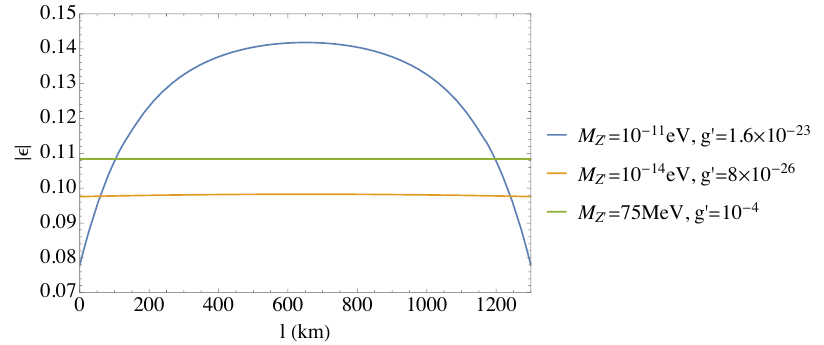
Figure 3 . Neutrino matter e(cid:11)ect in gauged L e (cid:0) L ‘ ( ‘ = (cid:22); (cid:28) ) model for three choices of g 0 and M Z 0 values. We consider a similar setup to DUNE, where neutrino travels 1300 km underground. For simplicity we assume both the source and the detector of neutrinos are located at the surface of the earth. In this case the largest depth of neutrino reaches is d max ’ 33 km, j (cid:15) j is plotted as a function of the distance l that neutrino has traveled. For the very short (long) range force case with M Z 0 (cid:29) d (cid:0) 1 ( M Z 0 (cid:28) d (cid:0) 1 ), we (cid:12)nd the j (cid:15) j is rough a constant as shown by the green (orange) max max curves; while for the intermediate range with M Z 0 (cid:24) d (cid:0) 1 , the variation of the matter potential max can be signi(cid:12)cant, as shown by the blue